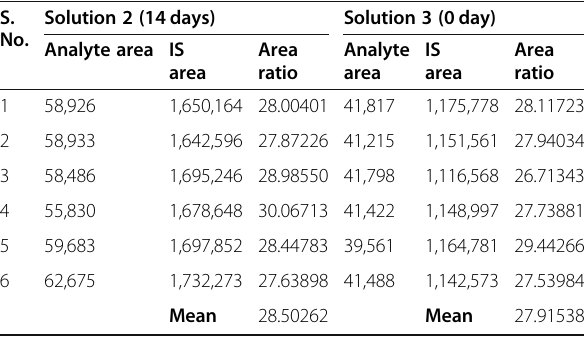
Table 16 Auto sampler stability for internal standard Stability hours